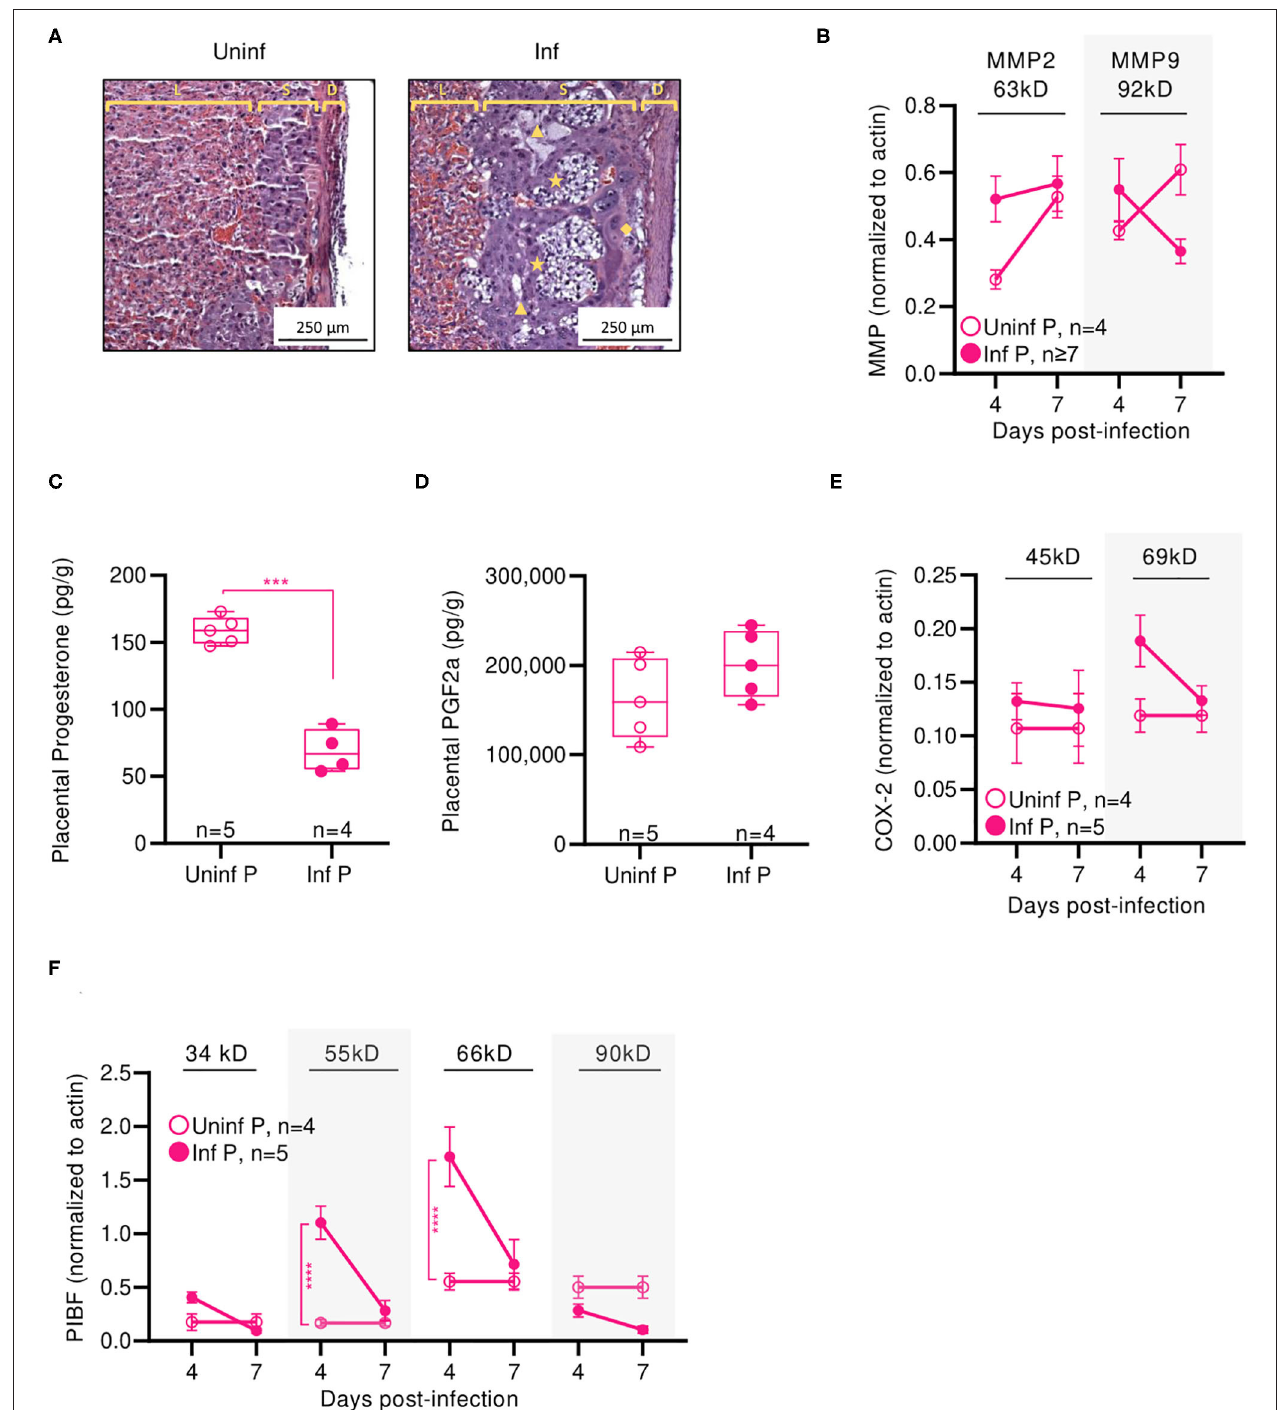
FIGURE 5 | Influenza infection induces short-term placental inflammation and subsequent vascular remodeling. (A) Representative H&E histology of placenta from mice infected with 0.5xLD50 or uninfected at 4 DPI (E14-16): spongiotrophoblast layer (S) between the decidual layer (D) and the placental labyrinth (L) with fetal cell hyperplasia [ ⋆ ] and empty space [ N ] distinct from maternal blood sinuses and fetal blood vessels and fibrinoid necrosis [ (cid:7) ] beneath the decidual layer. Western blots for (B) MMP2 and MMP9 proteins were run on at 4 and 7 DPI. Concentrations of progesterone (C) and PGF2 α (D) were determined in placental protein lysates at 4 DPI. Western blots for (E) COX-2 isoforms and (F) PIBF isoforms were run on at 4 and 7 DPI. COX-2 isoforms were observed at 45 and 69 kD. PIBF isoforms were observed at 34, 55, 66, and 90 kD. All Western bots were normalized to β -actin. Progesterone and PGF2 α data were analyzed using Welch’s t -test. Western blot data was analyzed using Two-way ANOVA using Sidak correction for multiple comparisons. *** p < 0.001; **** p < 0.0001.